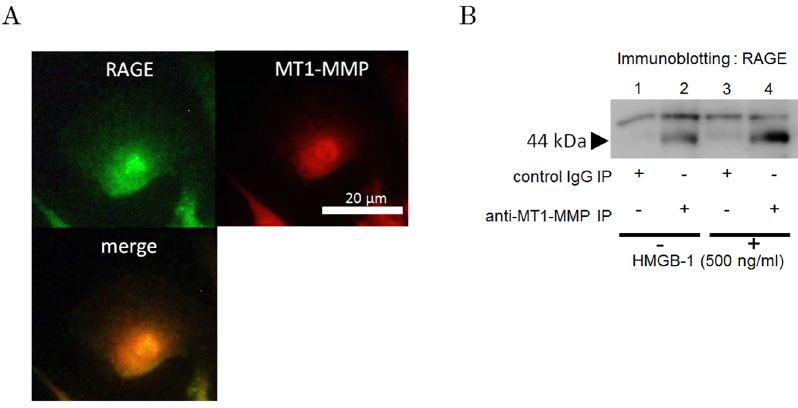
Fig. 6. Colocalization and binding of RAGE and MT1-MMP in endothelial cells. (A) Association of RAGE and MT1-MMP according to fluorescent immunohistochemistry. Merged image indicates that RAGE is partially colocalized with MT1-MMP. Photomicrographs are from an experiment representative of 3 independent experiments. (B) Formation of a complex of RAGE and MT1-MMP as determined by immunoprecipitation with or without HMGB-1 stimulation. Immunoprecipitates made using an isotype- matched control antibody did not show 44-kDa band (Fig. 6B, lane 1 and 3), whereas 44 kDa band recognized by immunoblotting with anti-RAGE antibody was detected in the MT1-MMP-immunoprecipitates (Fig. 6B, lane 2 and